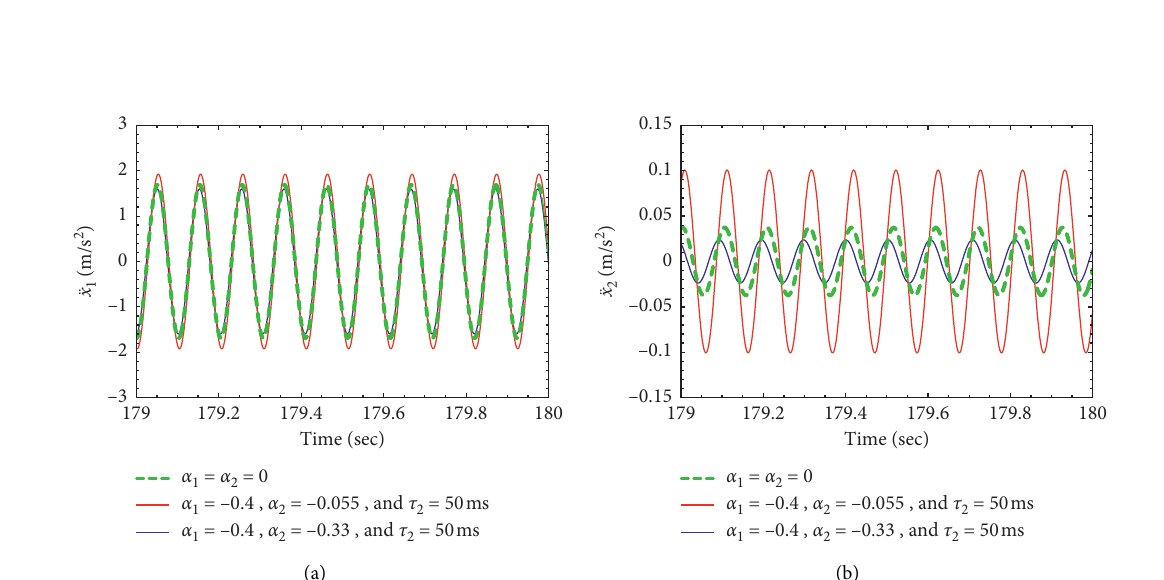
Figure 8: Numerical simulations of system responses for Ω � 9 . 75 Hz and f � 1N: (a) absorber and (b) primary system.